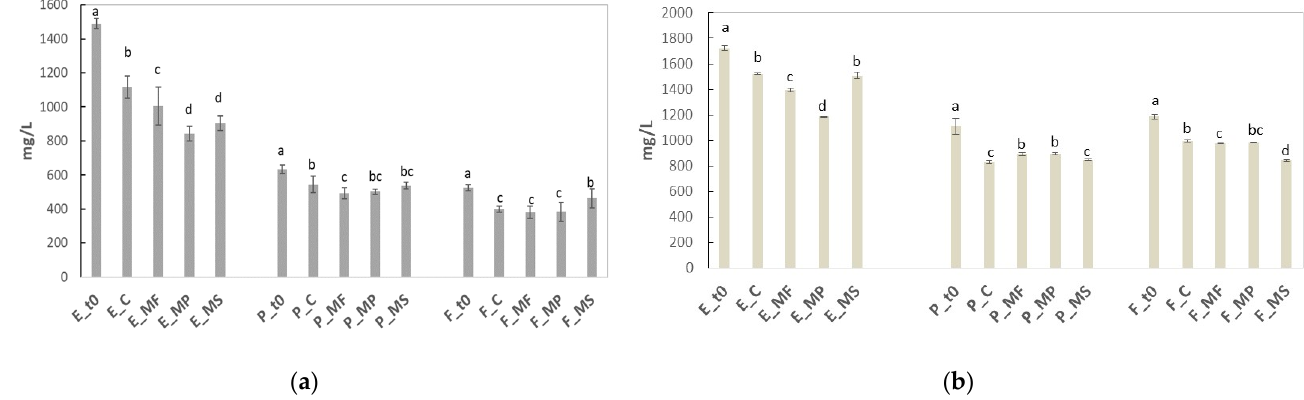
Figure 1. BSA-reactive tannins ( a ) and vanillin-reactive flavans ( b ) after six months of ageing on mannoproteins at 20 g/hL in extended maceration (E), marc-pressed (P), and free-run (F) Sangiovese wines. C represents the control wine; MF, MP, and MS are the mannoprotein treatments. t0 represents the wine before ageing. According to Fisher’s LSD analysis, histograms with different letters indicate significant differences for each wine typology ( p < 0.05).